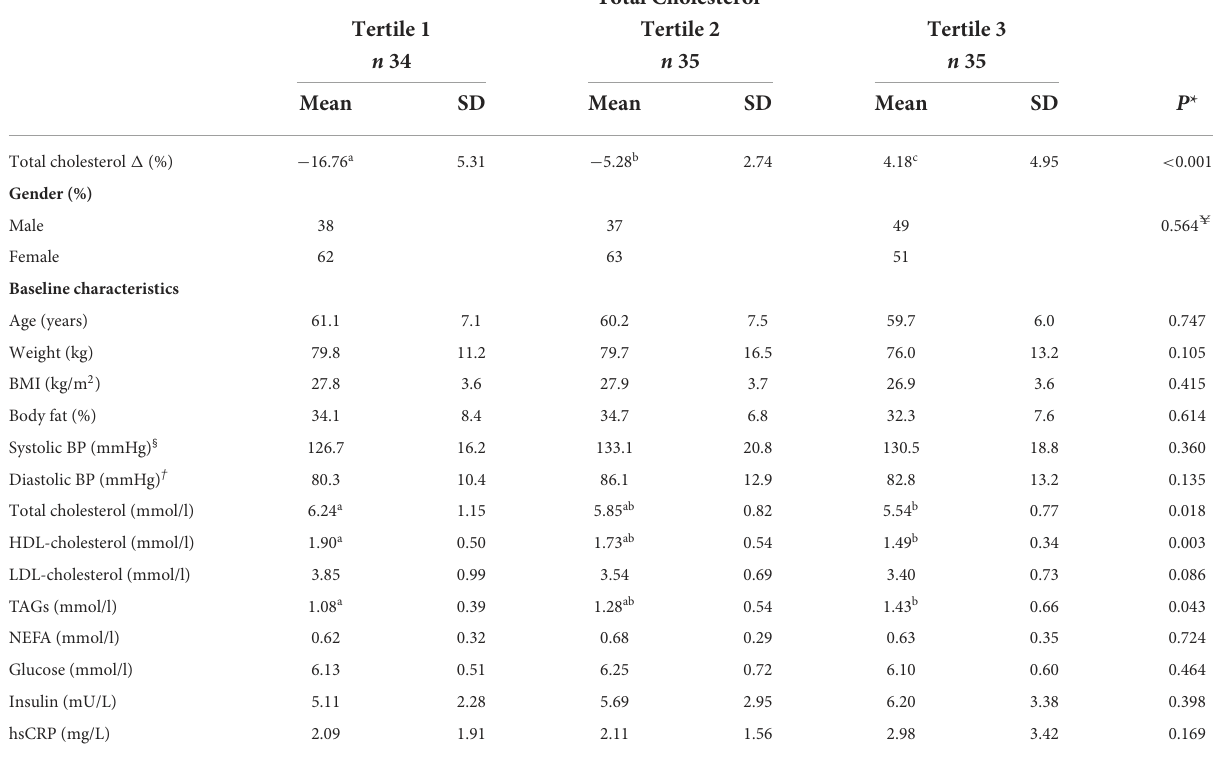
TABLE 3A Comparison of baseline characteristics across tertiles of percentage change in circulating serum total cholesterol levels for total